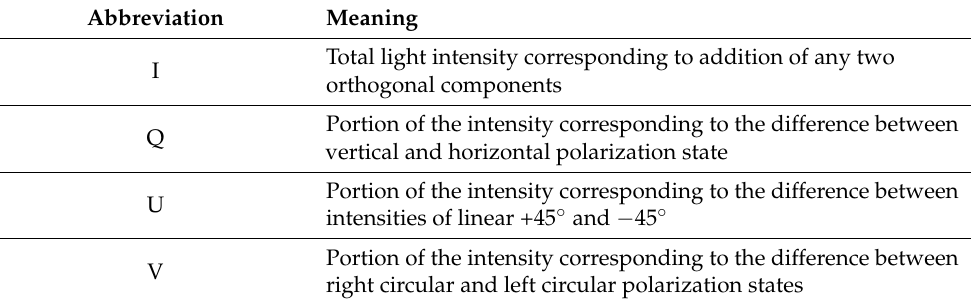
Table 1. Meaning of the four Stokes